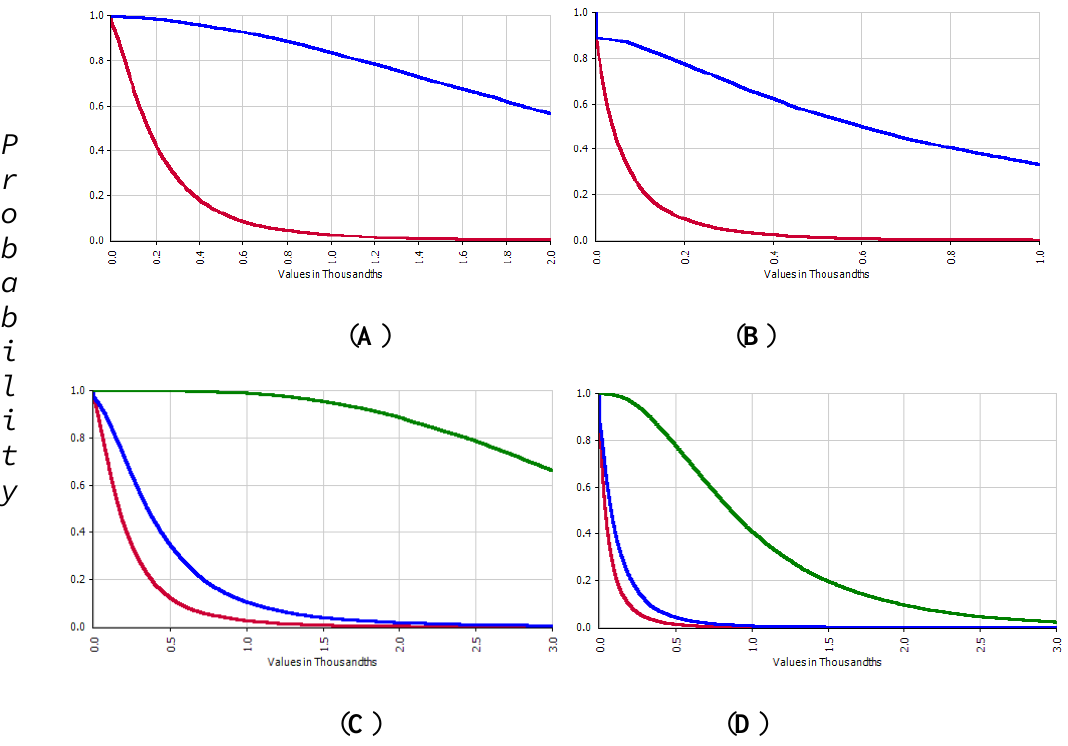
Figure 5. Skin cancer risk from using As contaminated water . Skin cancer risk with filter (red), +10 years (blue) and for lifetime (green) in Group 1 ( A ) and 2 ( B ) and without filter (blue) for Group 1 ( C ) and Group 2 ( D